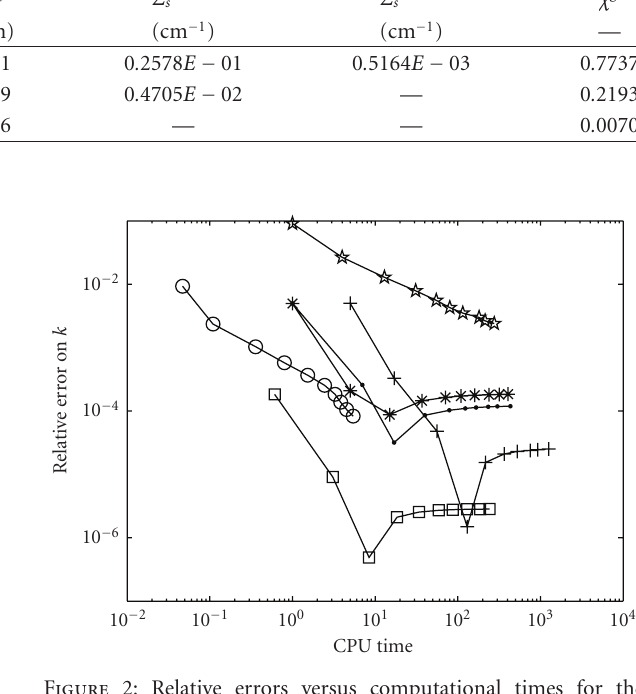
Figure 2: Relative errors versus computational times for the homogeneous reactor calculation. Identification of curves as in the previous